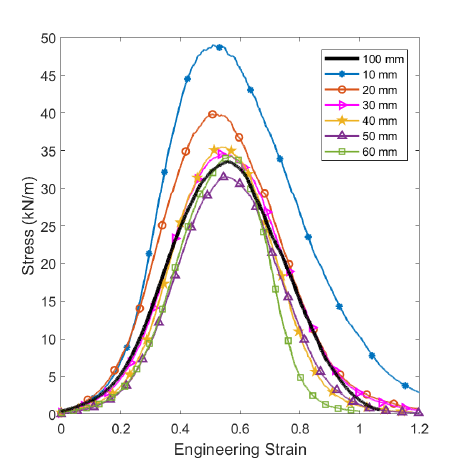
Figure 6. Representative nominal stress vs. engineering strain curves for different gauge lengths.